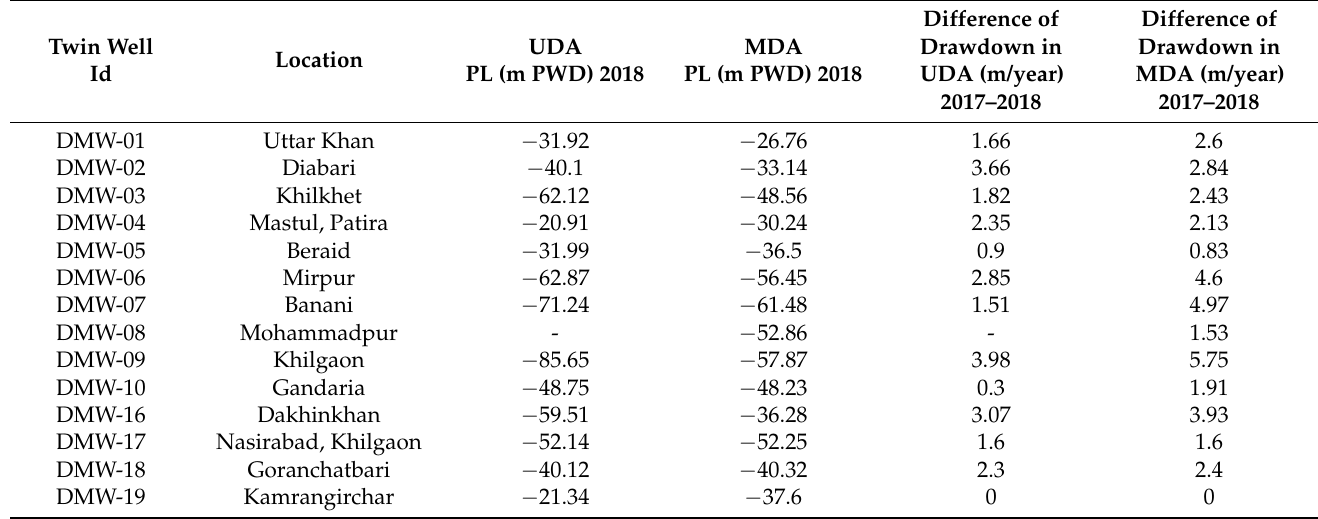
Table 1. The PL values and differences in drawdown in 2018 in twin monitoring